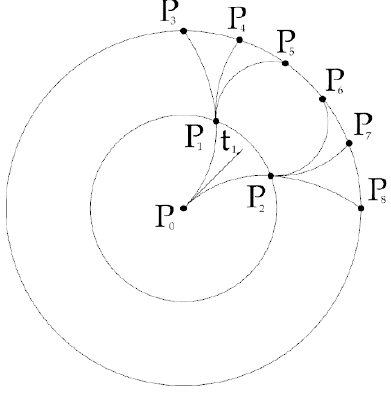
Figure 10. Point layers to control points conversion [22].